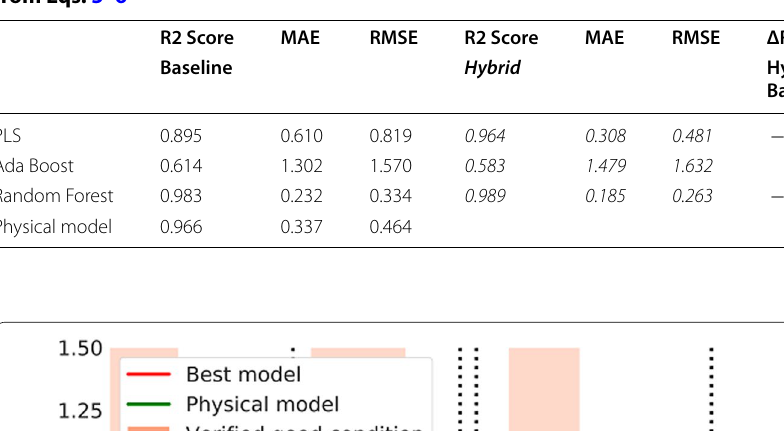
Table 4 Results of all models on the validation sets by means of the scores calculated from Eqs. 5–6